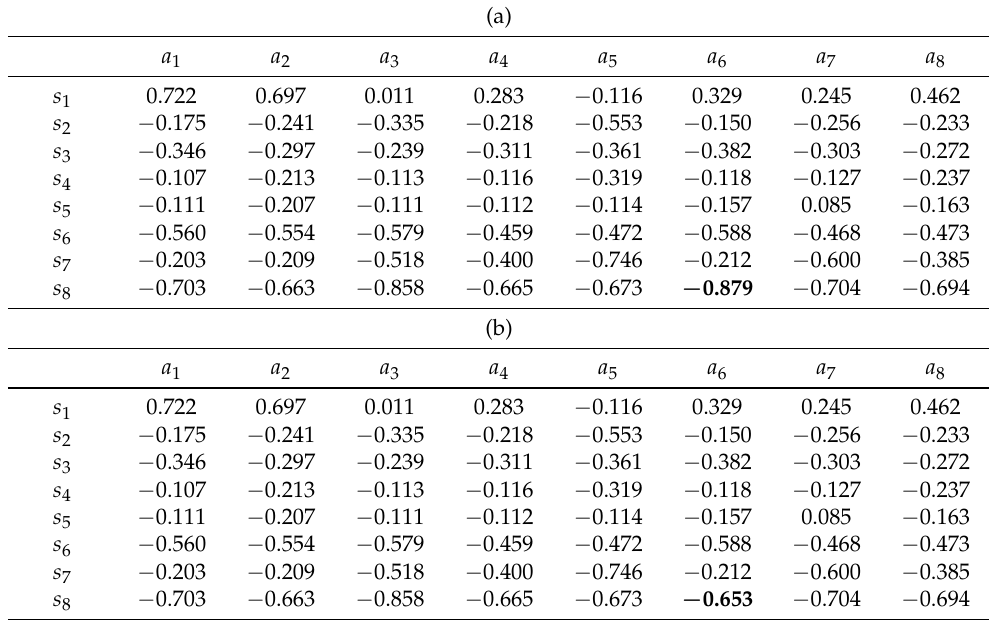
Figure 8. The updated process of state and action. Table 4. The update process of the